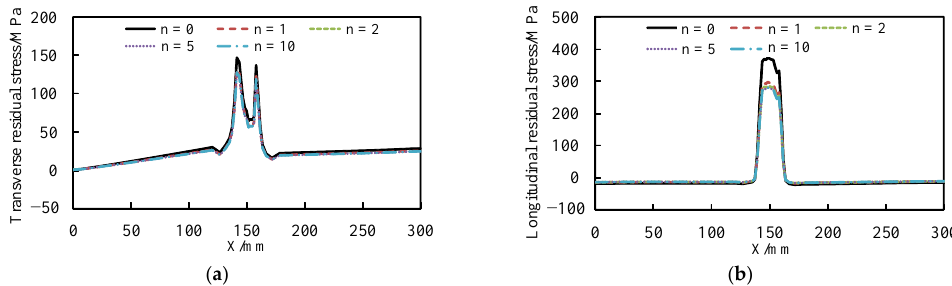
Figure 12. Distribution of residual stress along X -axis under external loading cycles from 0 to 10: ( a ) σ x ; ( b ) σ z .